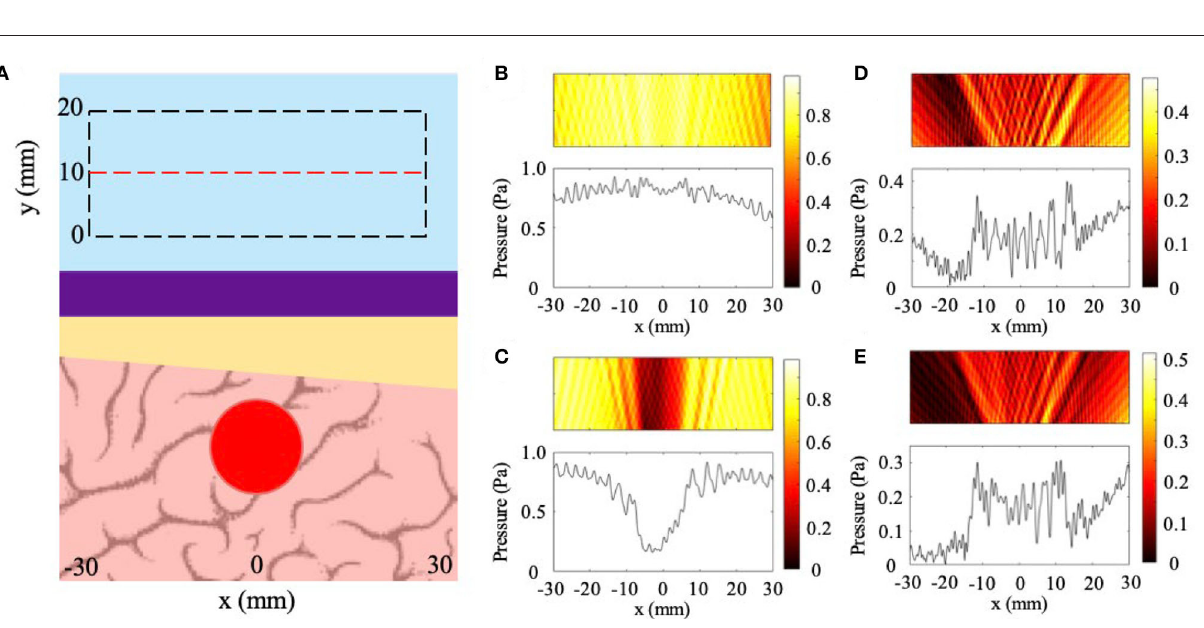
FIGURE 3 | Effects of skull sloping on ultrasound imaging with NHCMM. (A) Illustration of the skull sloping model used in full wave simulations. Plane wave incidence from the top of the subfigure. Reflected pressure fields are taken in the black dashed rectangles with the pressure amplitude recorded on the red dashed line. (B) Scattered pressure field from imaging through a skull with an internal slope of 1.67% compensated by a flat metamaterial. (C) Scattered pressure field from imaging through a skull with a larger internal slope of 3.33% compensated by a flat metamaterial. (D) Scattered pressure field from imaging through a skull with a 1.67% slope compensated by a metamaterial with the mirrored skull geometry. (E) Scattered pressure field from imaging through a skull with a 3.33% slope compensated by a metamaterial with the mirrored skull geometry. The colorbars represent pressure amplitudes in